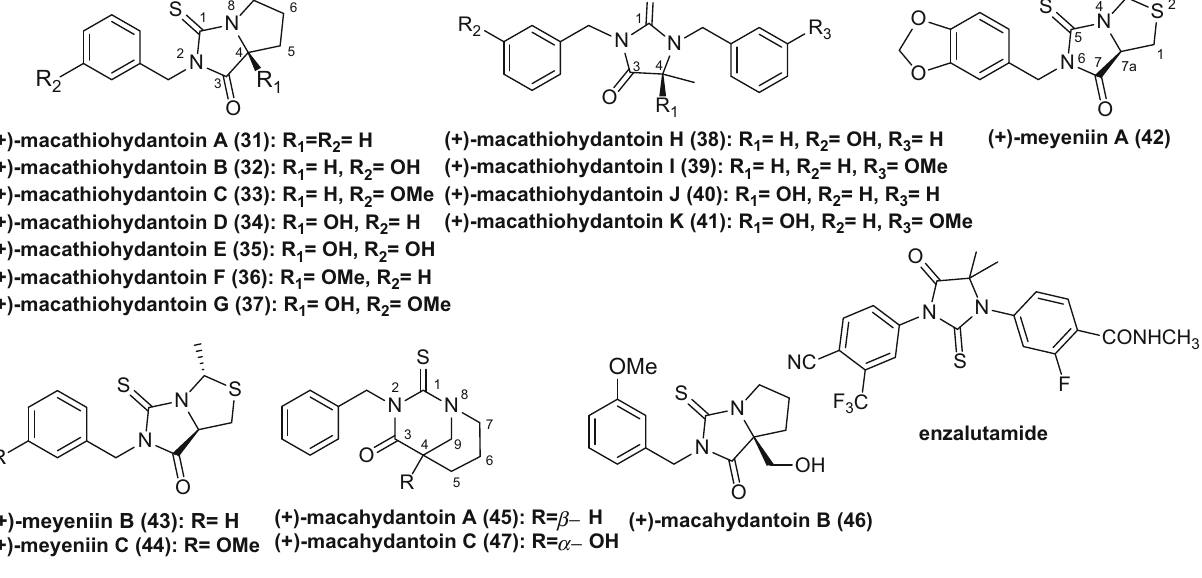
Fig. 3 Structures of thiohydantoins found in Maca and